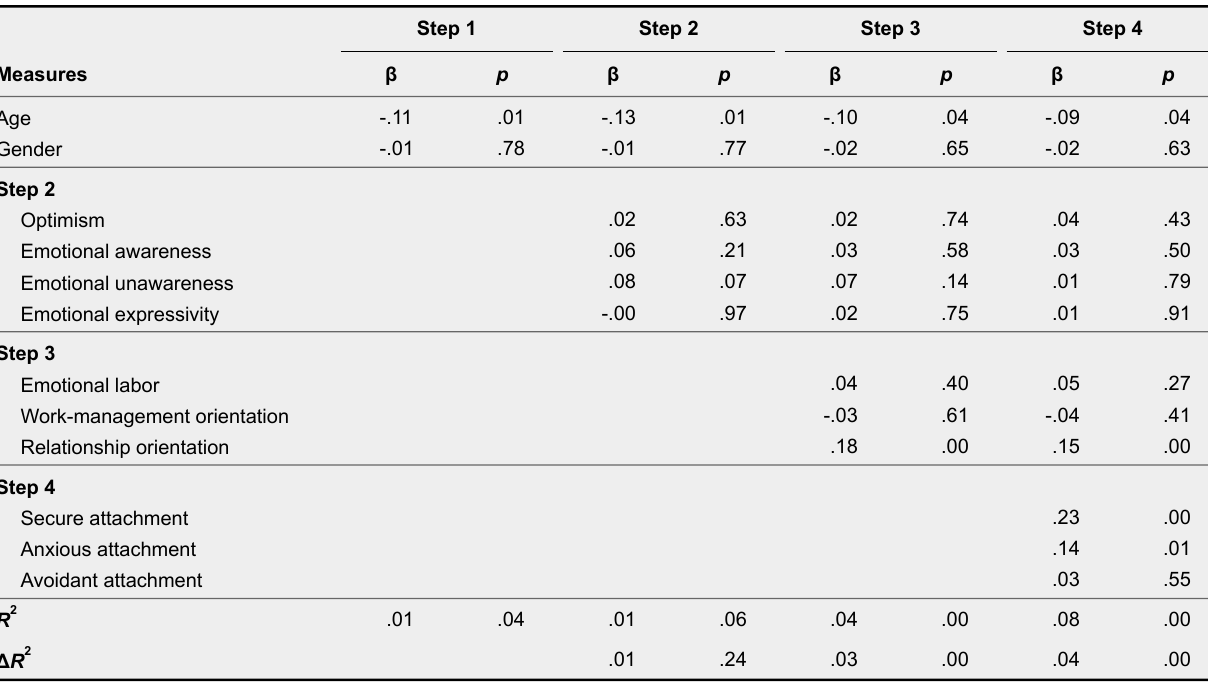
Hierarchical Multiple Regression of Job